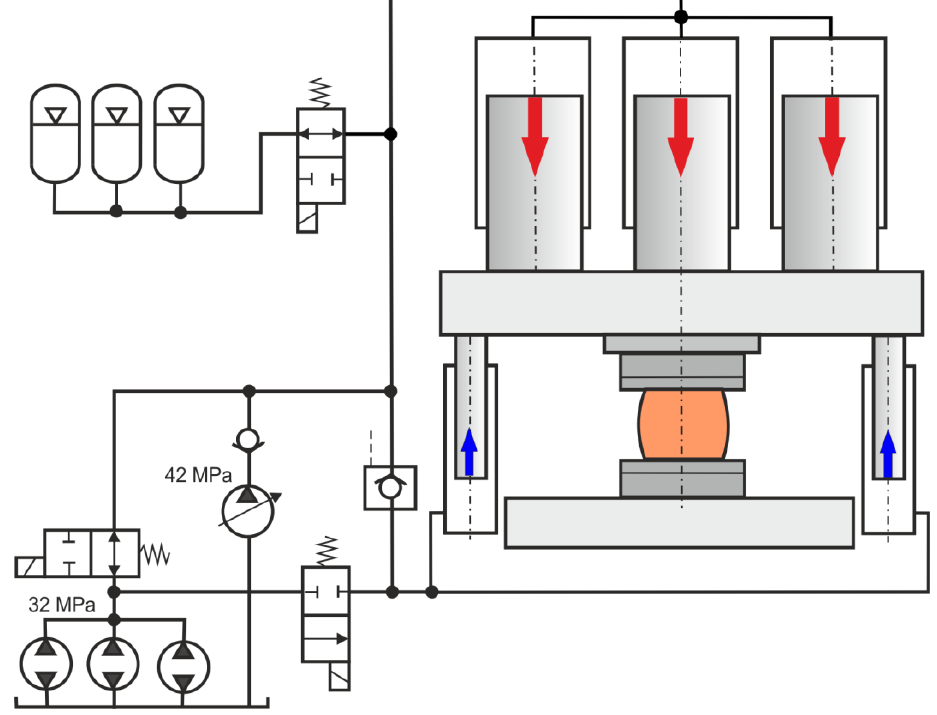
Figure 3. Diagram scheme of a hydraulic forging press with parallel connection of pumps.